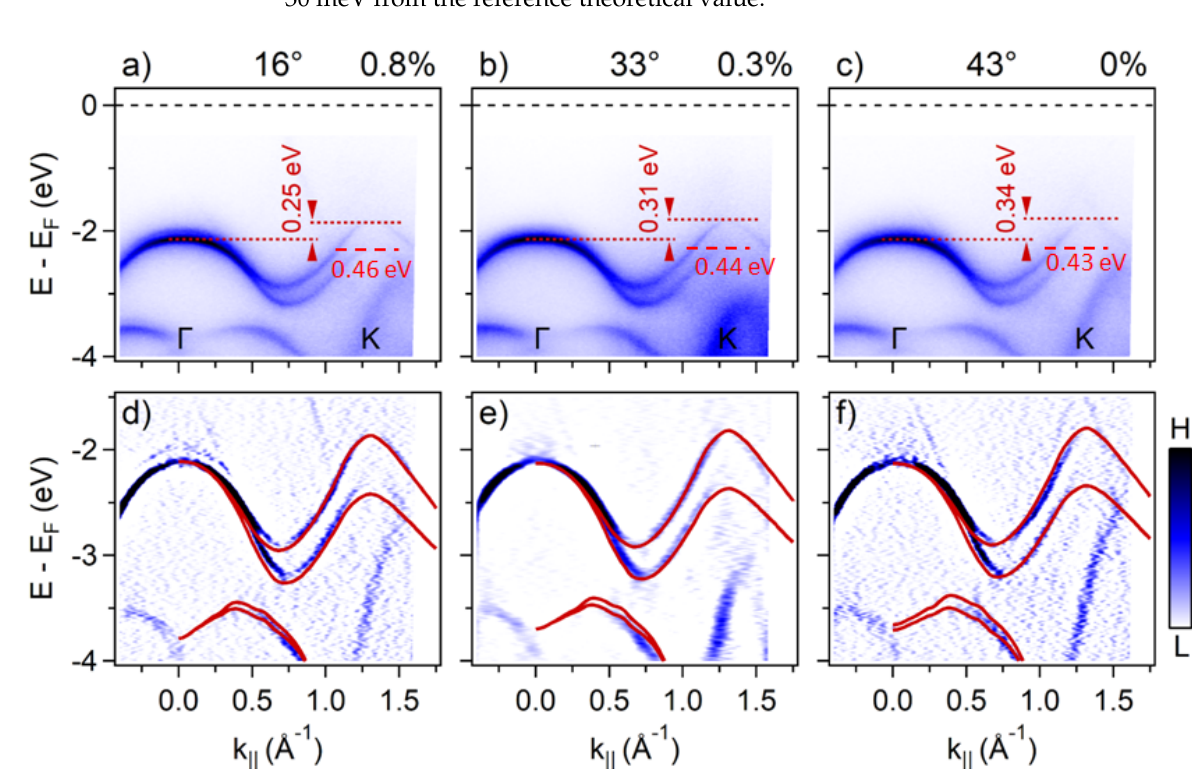
Figure 3. Evolution of the electronic band structure of the WS 2 /Gr heterobilayer at various twist angles: ( a – c ) ARPES band map along GK of the WS 2 layer, with twist angles of 16, 33, and 43°, respectively; ( d – f ) Corresponding second derivative spectra of the ( a – c ) panels on which the calculated band structure obtained by HSE06 (red lines) is superimposed. The tensile biaxial strain used in the simulations is marked next to the experimental twist angle.